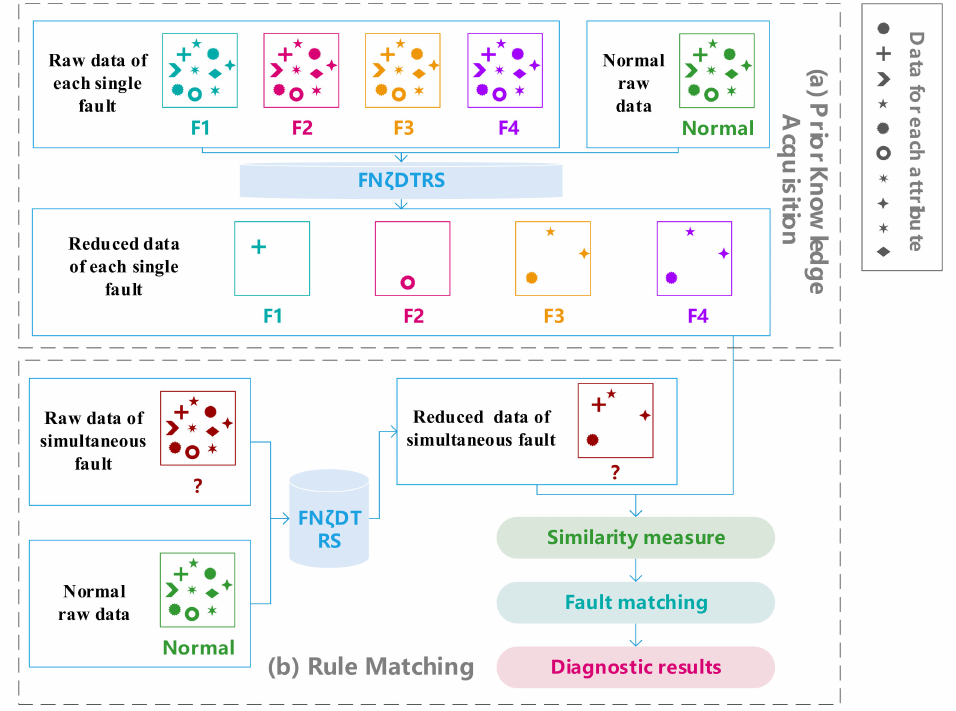
Figure 2. The procedure of fault diagnosis strategy for